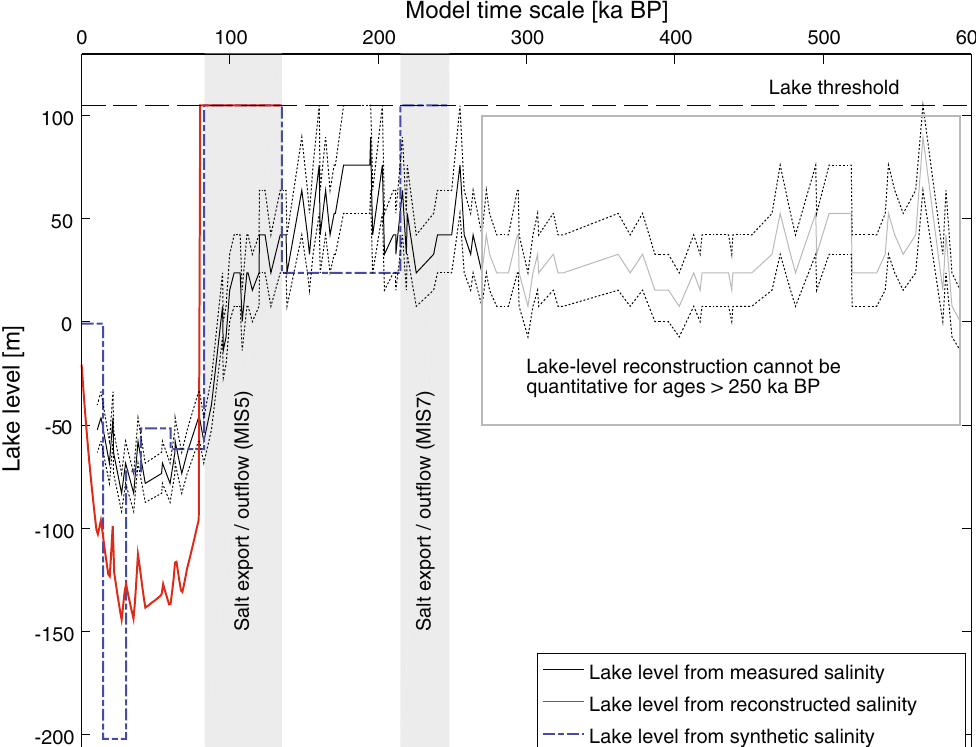
Figure 4. Lake-level reconstruction for Lake Van. Changes in lake level with respect to the present lake level at 1645 m a.s.l. (solid black line) were calculated from salinity measurements in the pore water of ICDP PaleoVan core-catcher samples (Fig. 2, black dots). Note that the model time scale (x-axis) refers to changes in salinity in the open water column, which sets the top hydrochemical boundary condition for the modeling exercise (Fig. 2). Dotted lines represent the error range given by the precision of the salinity measurements. The red line shows the lake level calculated from the reconstructed salinity curve (Fig. 2, right-hand panel, red line). The dashed blue line depicts the lake level based on the synthetic salinity curve (Fig. 2, right-hand panel, dashed blue line) and on seismic and sedimentological information. The salinity minimum between 50 and 80 m (Fig. 2, left-hand panel) can be interpreted as two high lake stands + 105 m above the current lake level at an altitude of 1750 m a.s.l., where the basin morphology allowed Lake Van to overflow. For ages beyond 250 ka the lake-level reconstruction cannot be interpreted quantitatively (gray line), as the measured salinity most likely reflects the long-term steady-state salinity of the